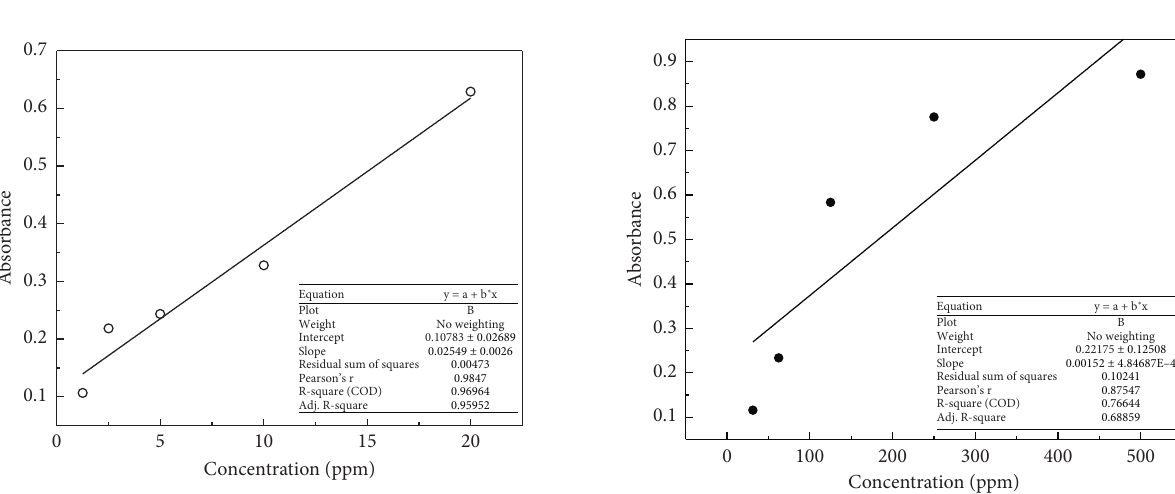
Figure 13: Calibration curve (linear fitting) for determination of nitrite